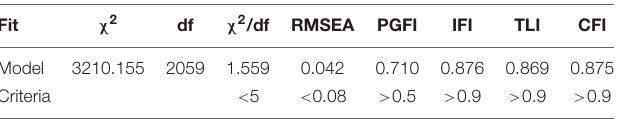
TABLE 9 | Goodness of fit by modified